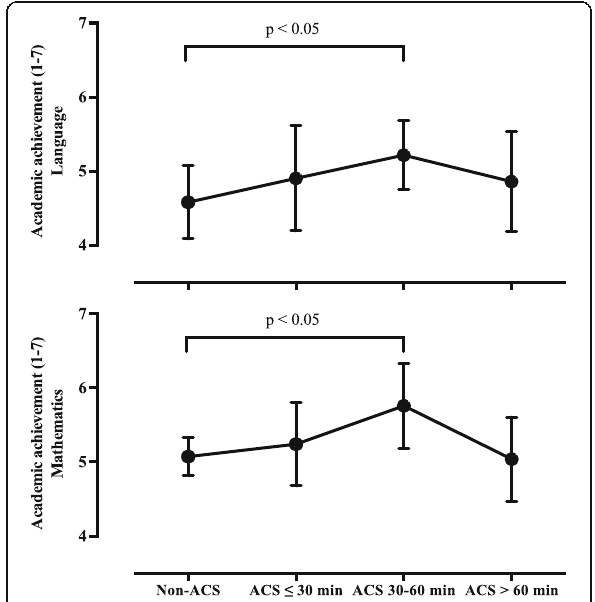
Fig. 1 Mean differences in academic achievement by categories of active commuting to school. ACS, active commuting to